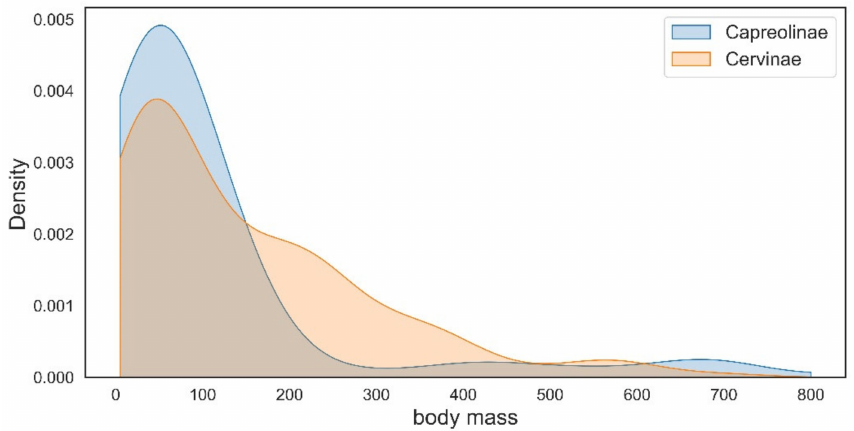
Figure 10. The distribution of body size within the cervid subfamilies Cervinae and